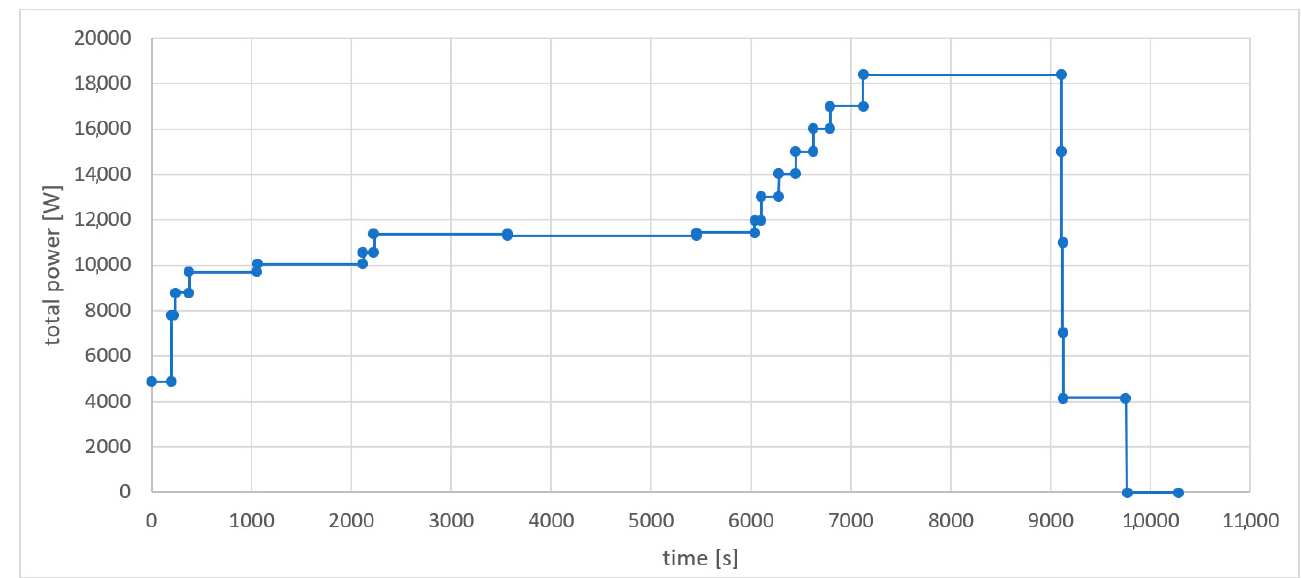
Figure 4. Model nodalization—core.